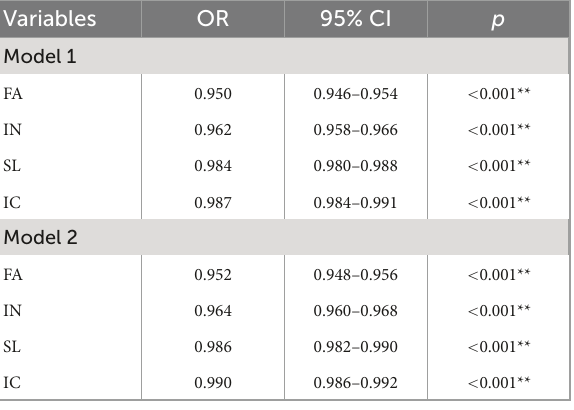
TABLE 1 Demographic characteristics of participants ( N = 3014).